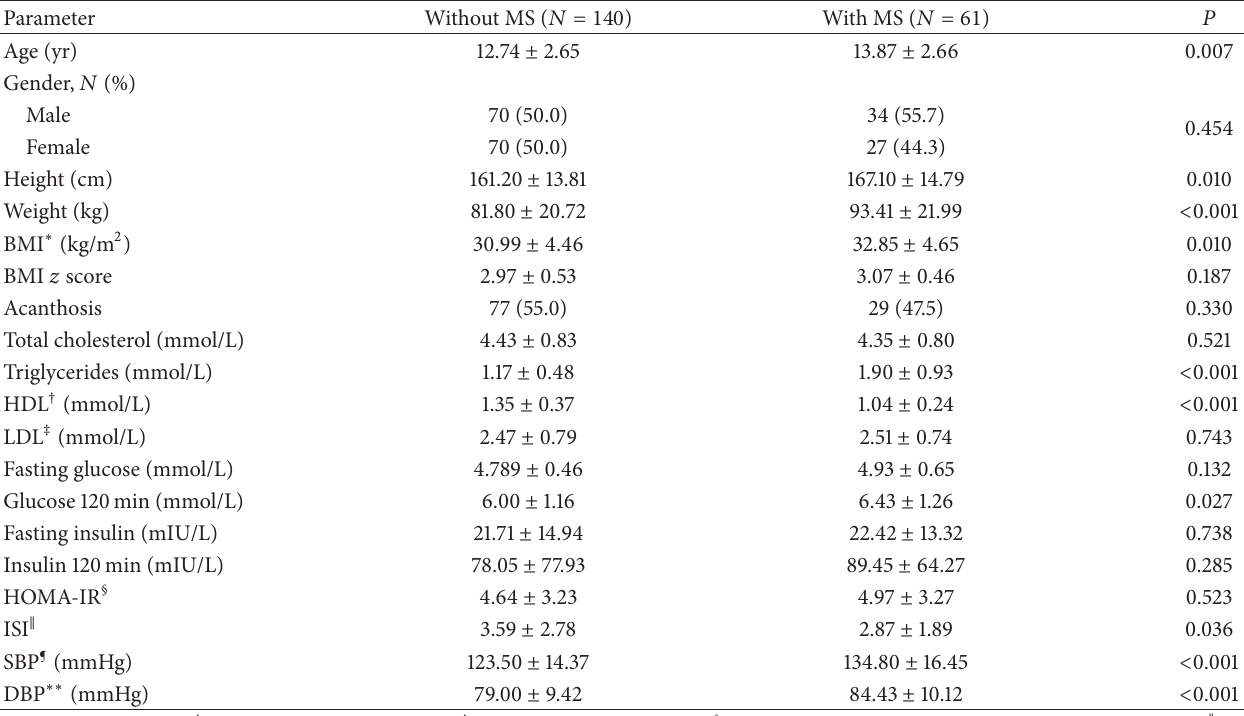
Table 4: Anthropometric and biochemical characteristics of children with and without